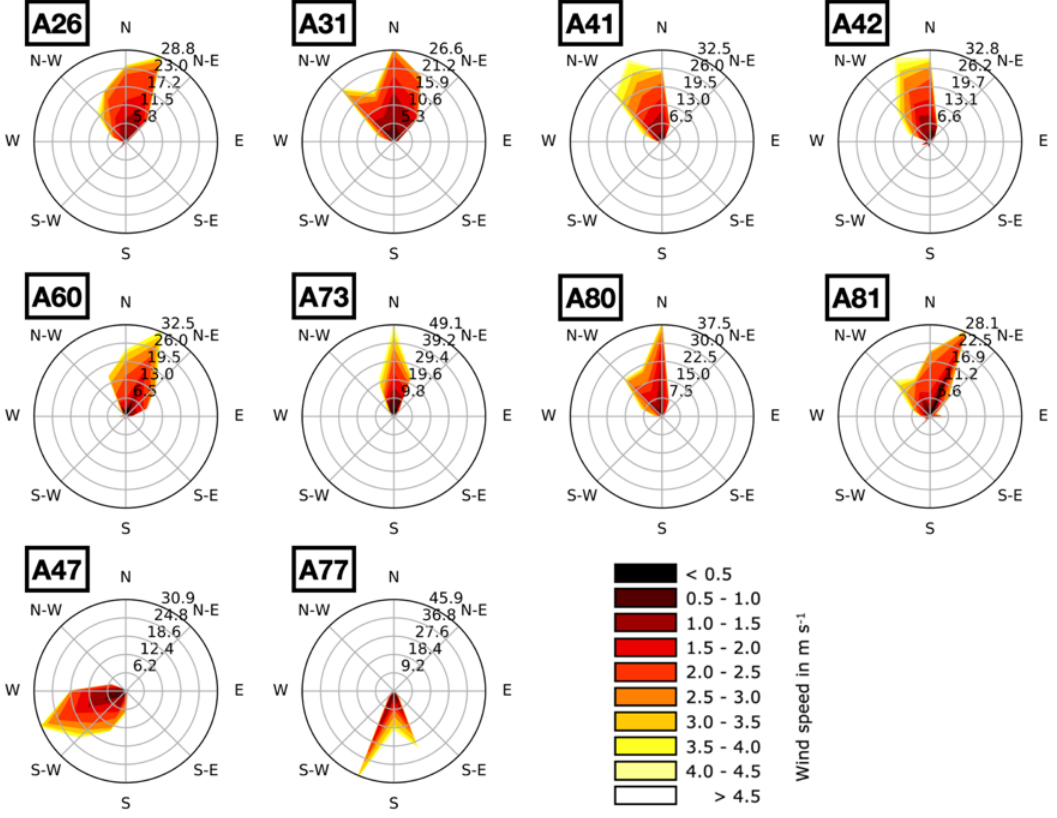
Figure 5. Windroses show the wind speed and direction measured at the 10 anemometers considered upwind of the burn plot. Circular levels indicate percentage of time a wind direction was observed, and colors indicate associated wind speeds. Anemometers A47 and A77 at the bottom were excluded from this study due to large differences in wind direction relative to the other sensors.